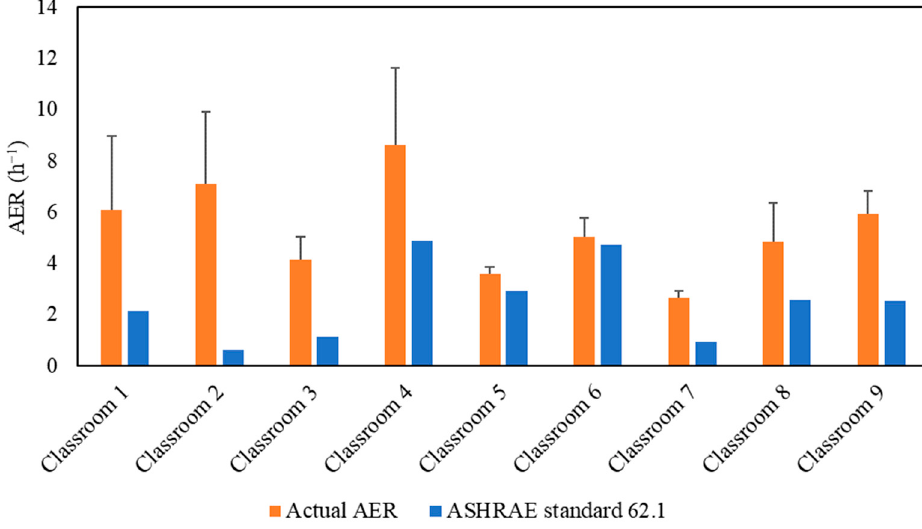
Figure 2. Air exchange rate ( AER ) values for the tested classrooms. The error bars indicate standard deviations of the values measured on three different